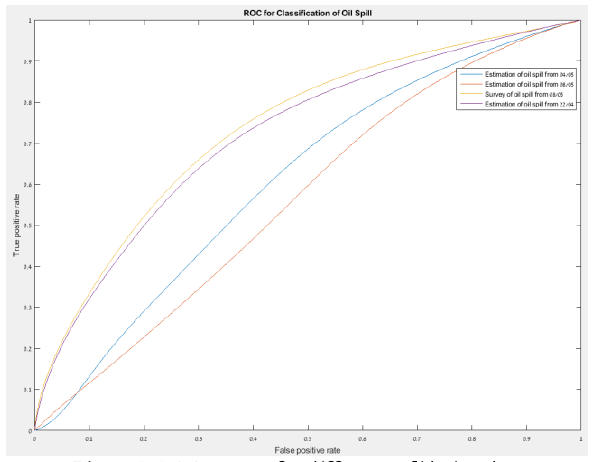
Figure 7. ROC curves for different validation data